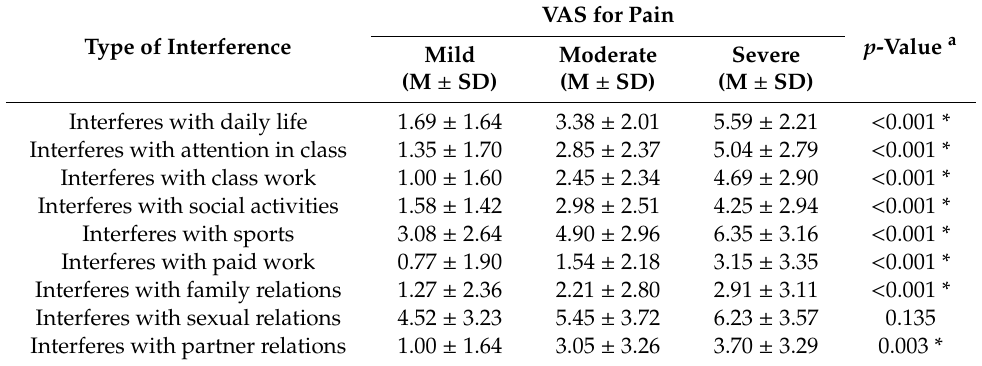
Table 4. Degree of interference self-reported by students with mild, moderate and severe